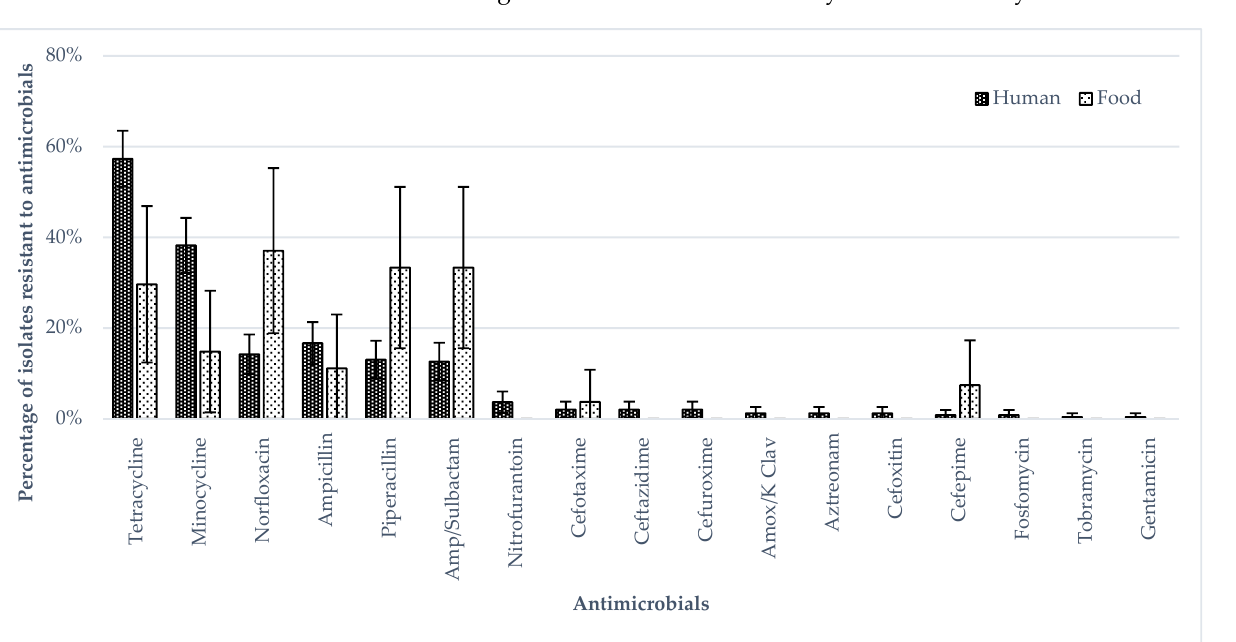
Figure 1. Phenotypic antimicrobial resistance in S. enteritidis isolates, comparing human and food isolates.